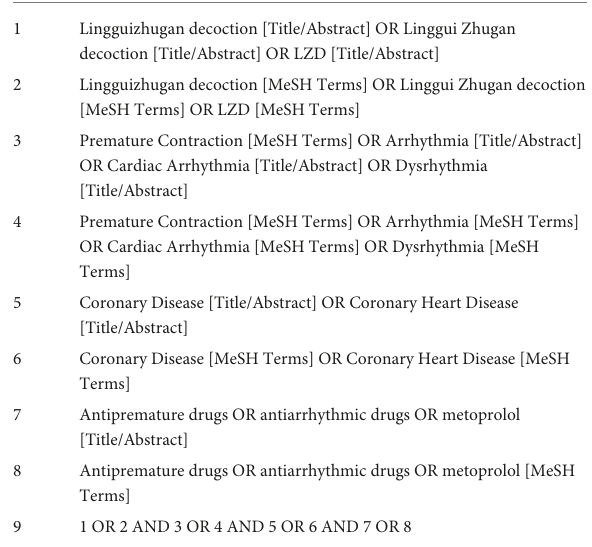
TABLE 1 MeSH terms and title/abstract in search strategy applied to PubMed. Items Search